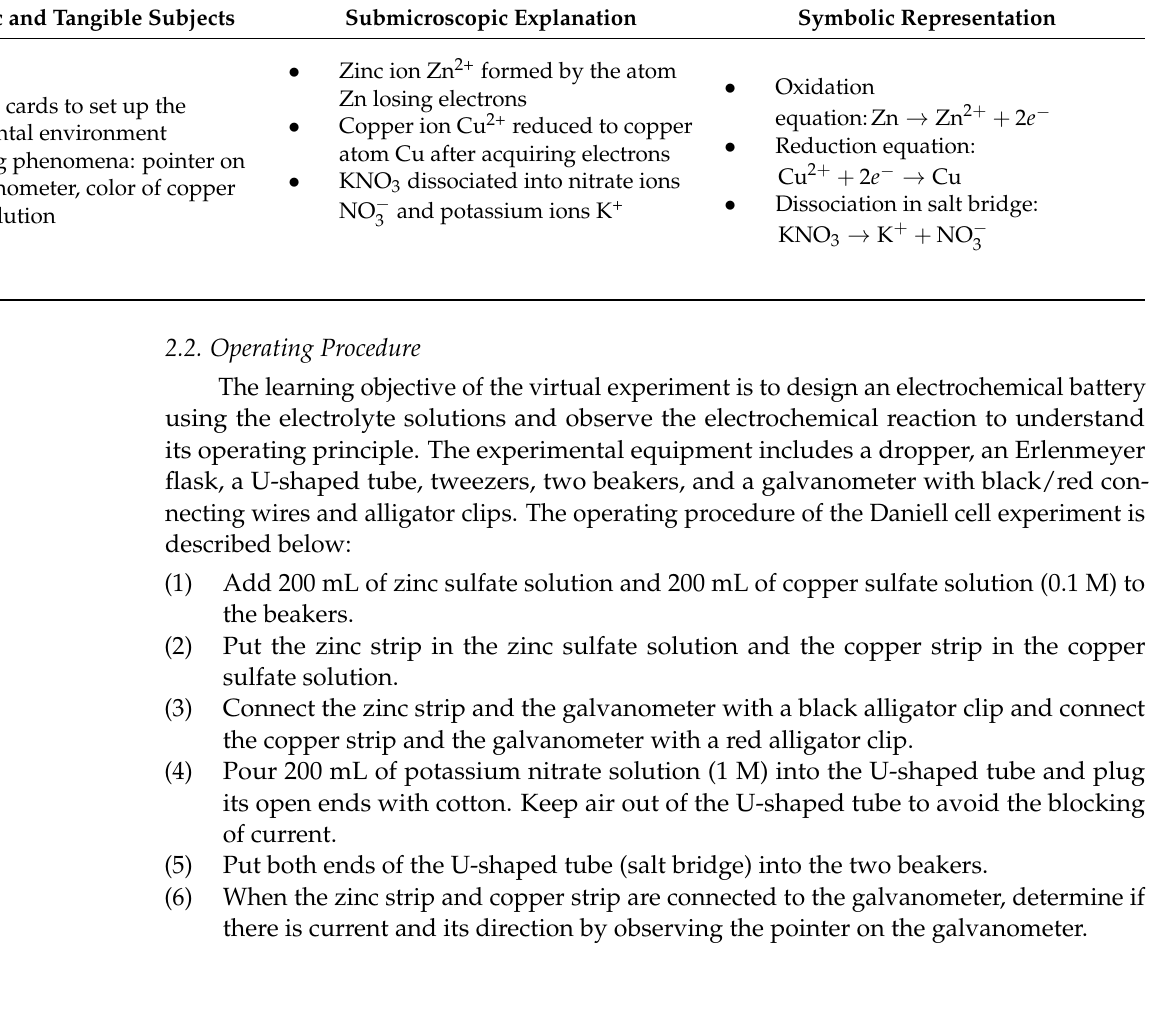
Table 1. Three levels of chemistry knowledge for designing the virtual experiment. Macroscopic and Tangible